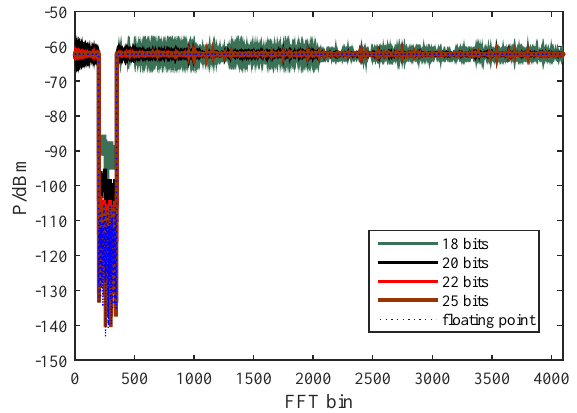
Figure 9. Slot noise test for various internal FFT bit size configurations, 14-bit ADC, power normalized to a 50 Ω input resistance, slot size = 150 bins. A size of 25 bits for the FFT internal calculations achieves the least slot noise compared to a floating point implementation. Magnitude evaluation and averaging are implemented with full precision to avoid any performance